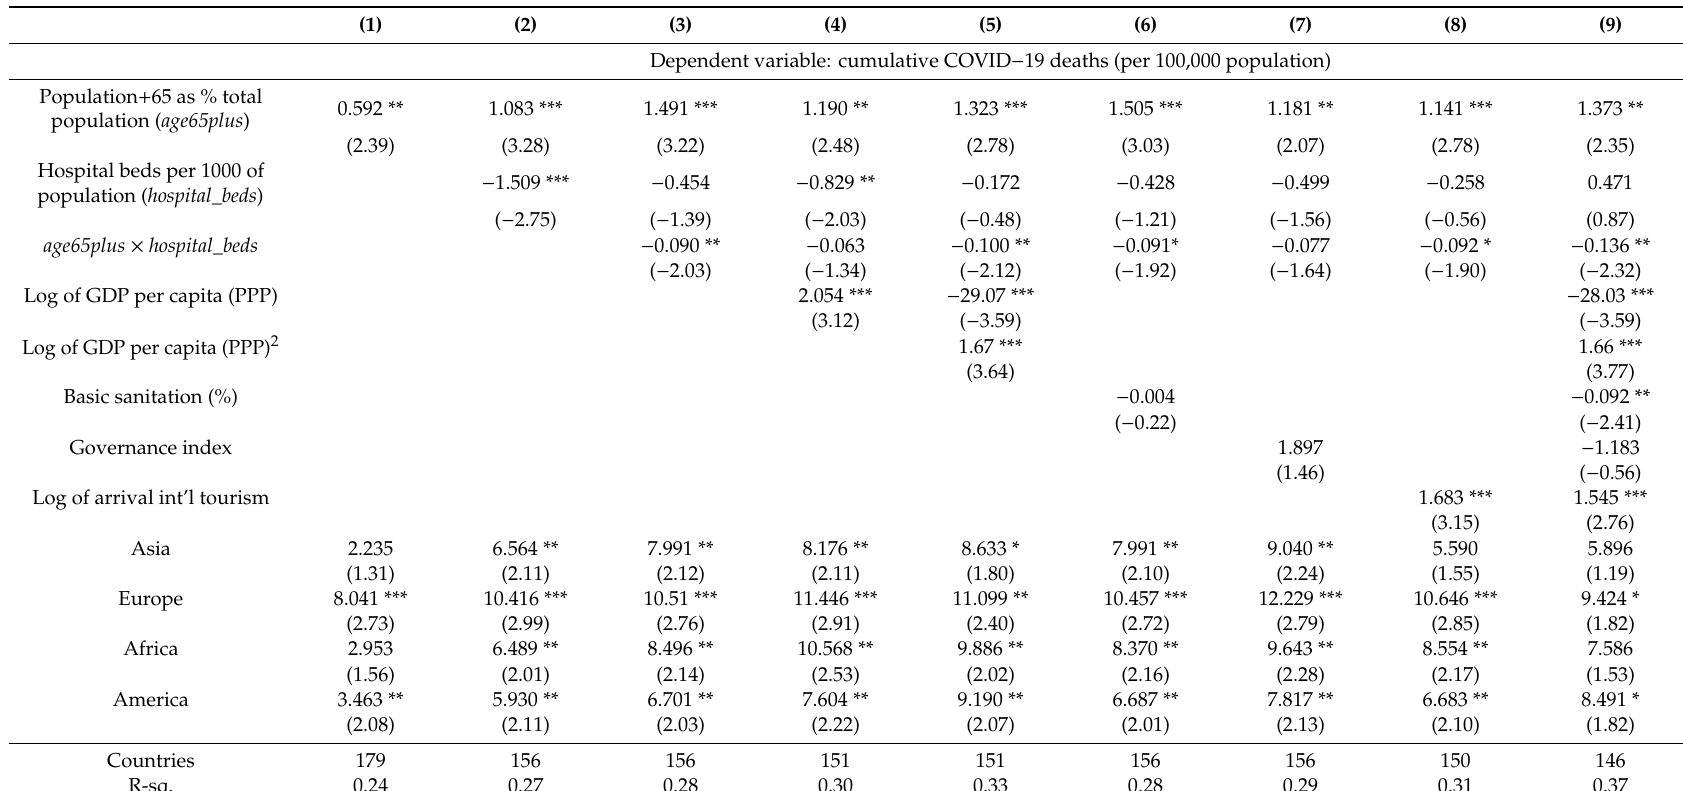
Table 2. COVID-19 mortality and elderly